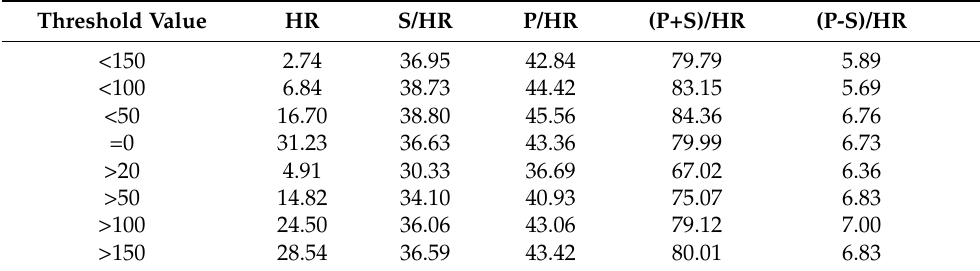
Table 2. The percentage of reconstruction results of different methods with × 4 scale in Sobel texture region of label image on city video sequence of Vid4